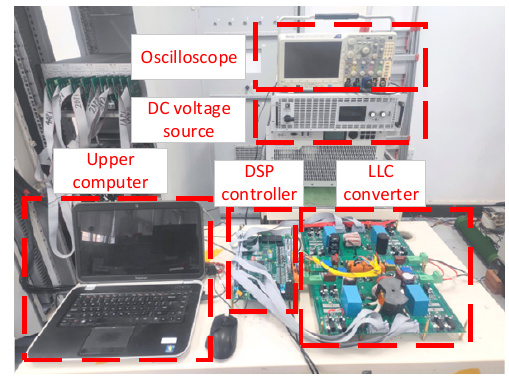
Figure 7. Actual experimental